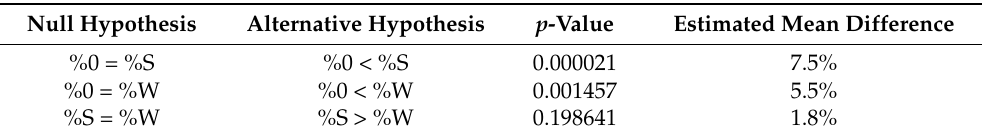
Table 3. t ‐ test results. Table 3. t -test